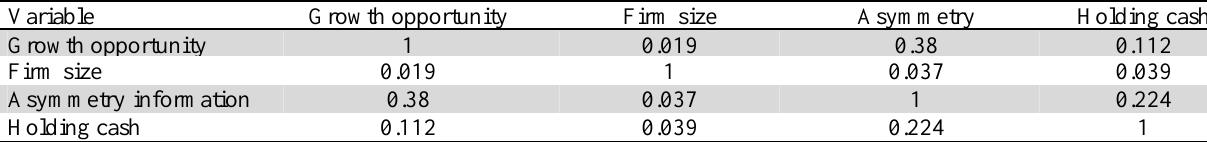
Variable Growth opportunity